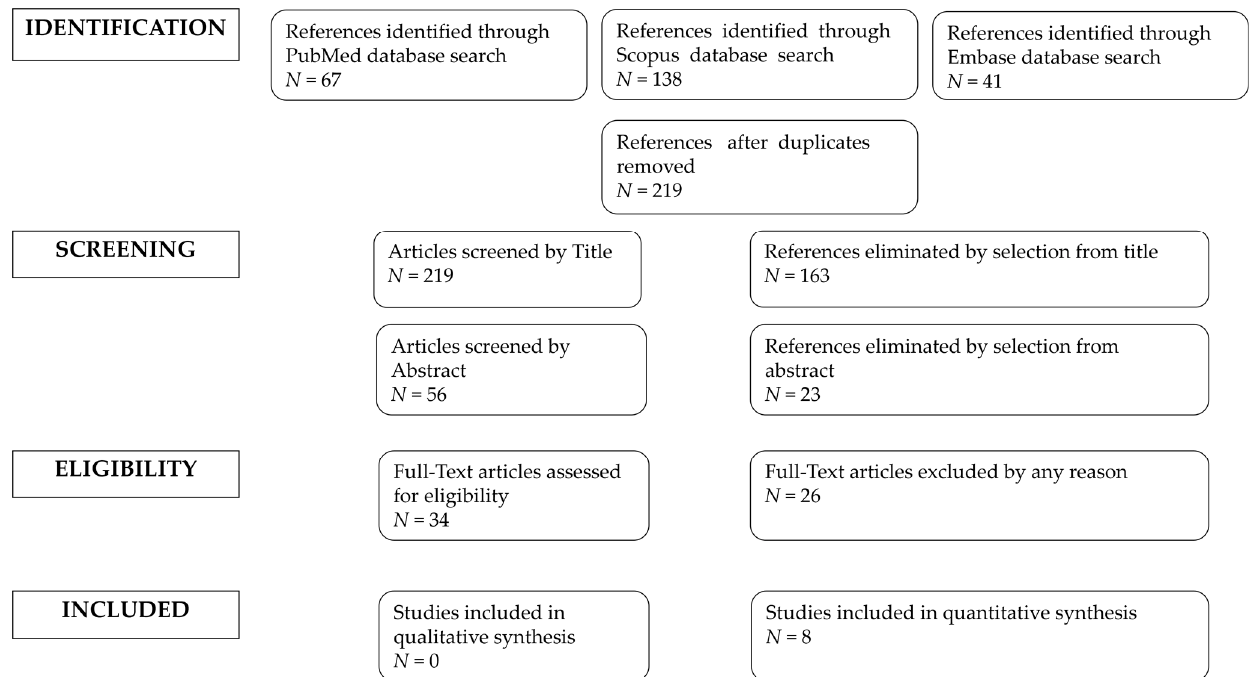
Figure 1. Preferred reporting items for systematic reviews and meta-analyses (PRISMA) flowchart.